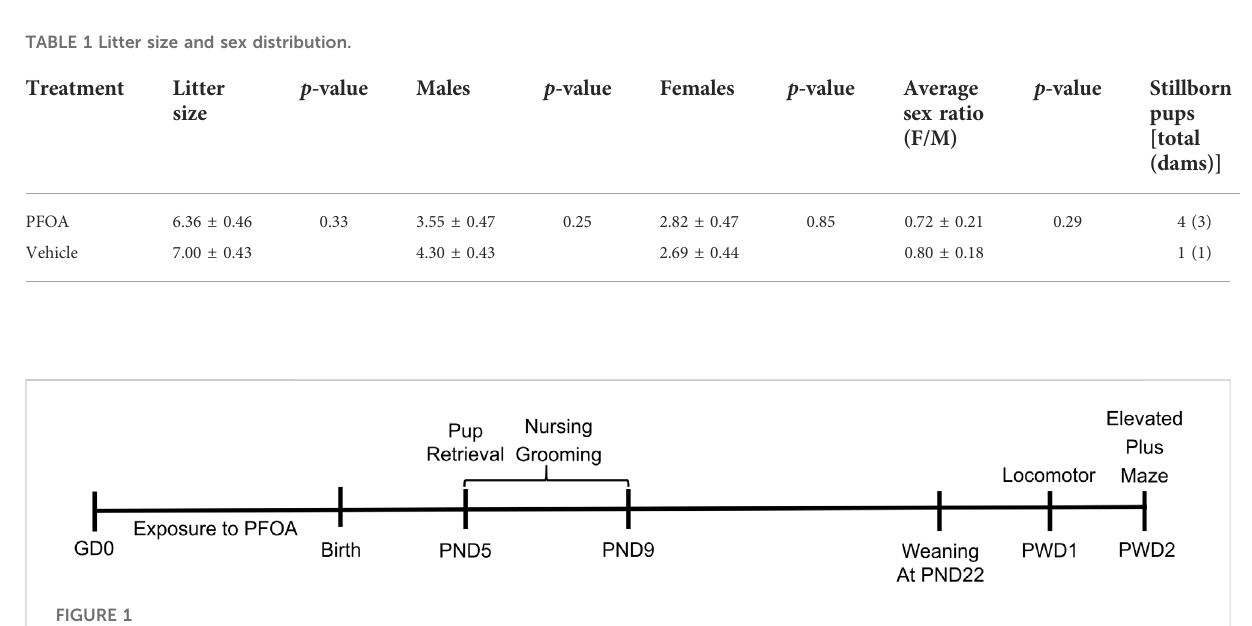
FIGURE 1 Experimental Timeline. Dams were orally exposed to PFOA or vehicle from gestational day (GD) 0 till birth. Following birth, maternal behavior was quanti fi ed over postnatal days (PNDs) 5 – 9, with pup retrieval assess on PND 5. After weaning on postweaning day (PWD) 1 dams